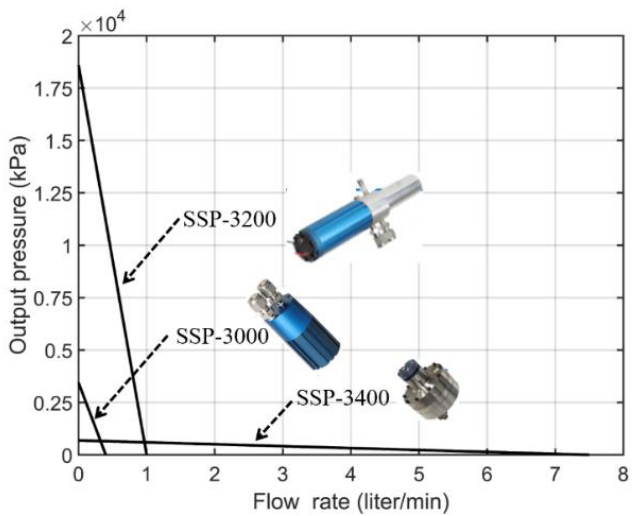
Figure 17. Summary of the performance of commercial piezoelectric-hydraulic pumps from Kinetic Ceramics company (solid-state pump SSP) (from [164]).